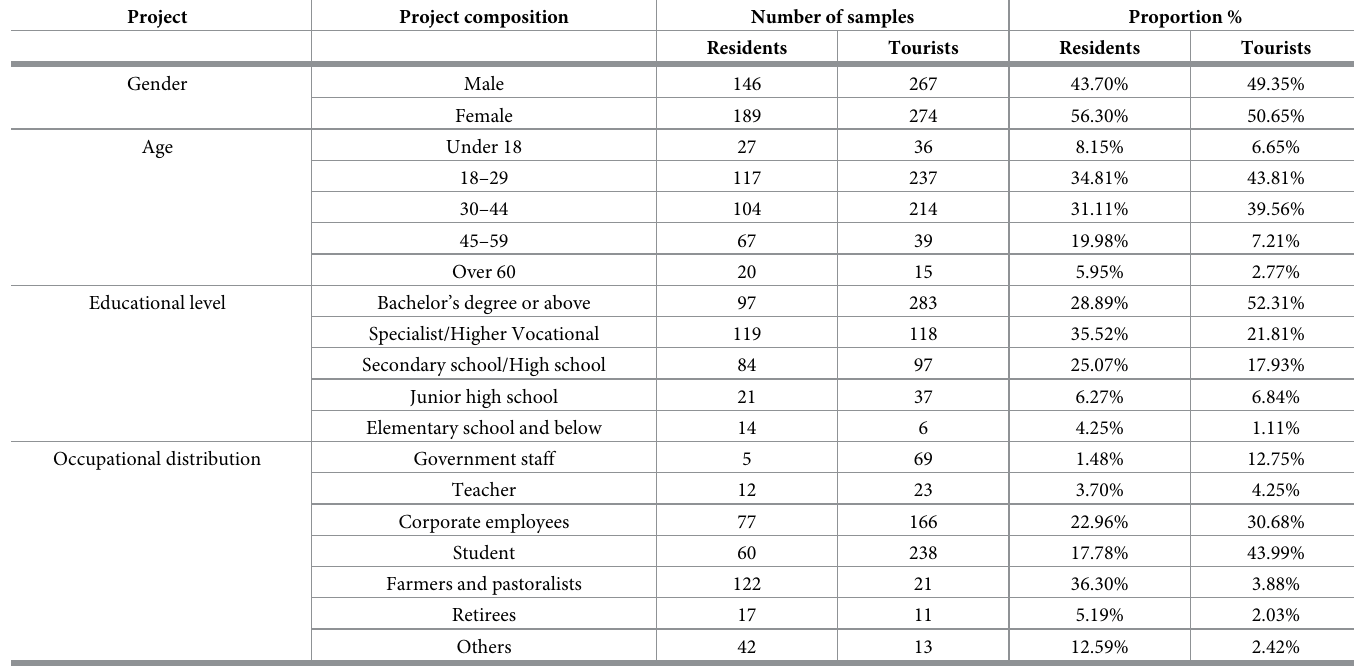
Table 4. Demographic characteristics of residents and tourists.